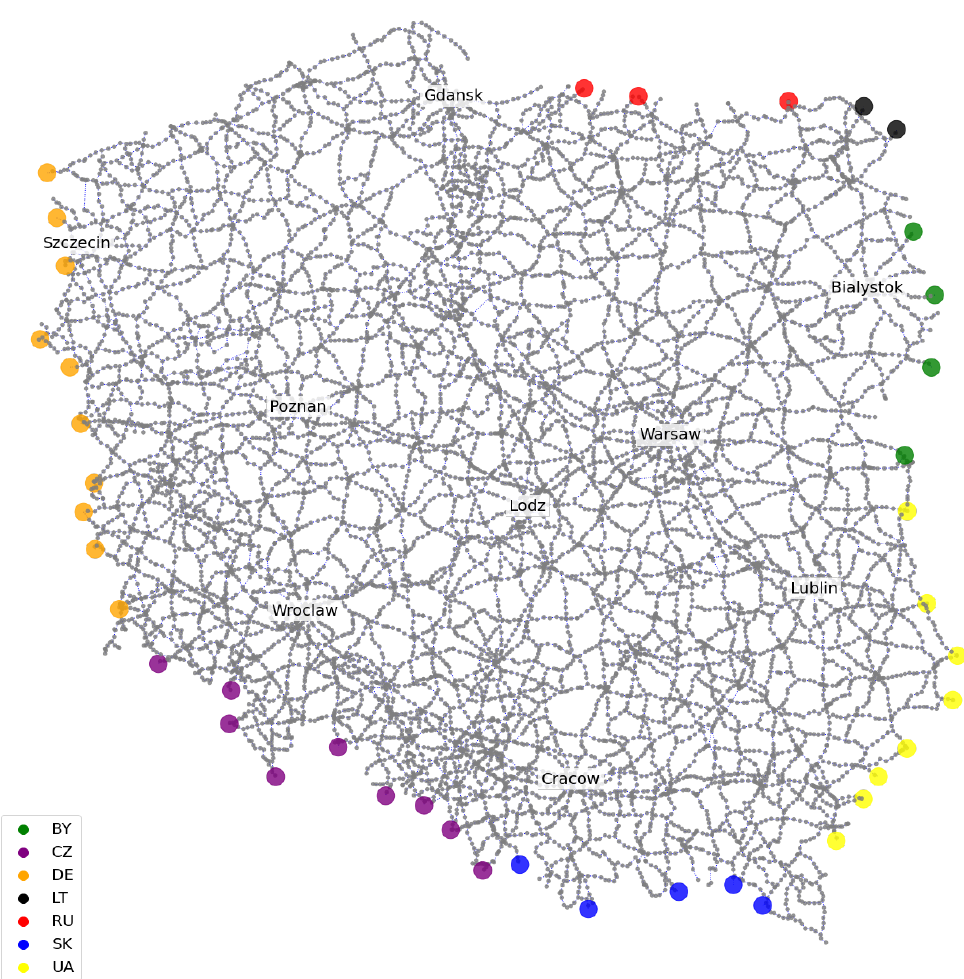
Figure 3. Location of border crossings on the road transport network of Poland.